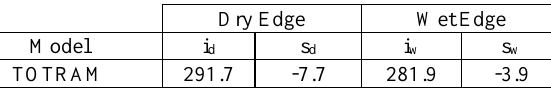
Table 1. TOTRAM [Eq. (3)] parameters obtained for the Mashhad City and Landsat-8 satellite data.